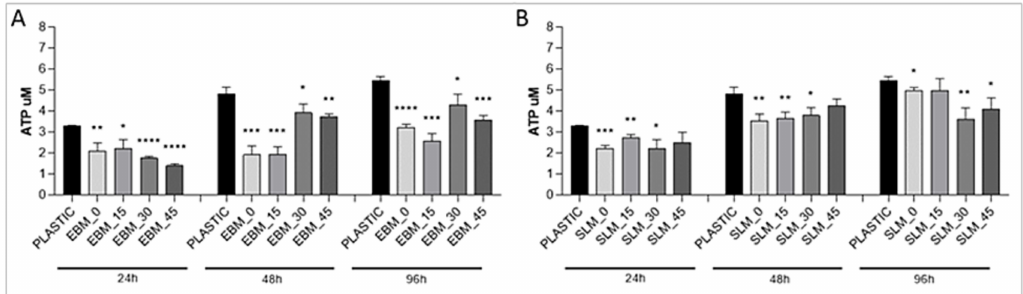
Figure 6. Measurement of the number of viable cells in culture with a luminescent signal proportional to the amount of ATP present. ATP ( µ m) concentrations of MC3T3-E1 cells cultured on EBM ( A ) and SLM ( B ) titanium sca ff olds and on a plastic well plate (as control), estimated at di ff erent time points (24 h, 48 h and 96 h). Error bars represent SD derived from three di ff erent experiments ( n = 3). Significant di ff erences were analyzed between the positive control (cells on plastic dish) and each sca ff old using unpaired t -test. A value of p < 0.05 was considered statistically significant (* p < 0.05, ** p < 0.01, *** p < 0.001, **** p < 0.0001).